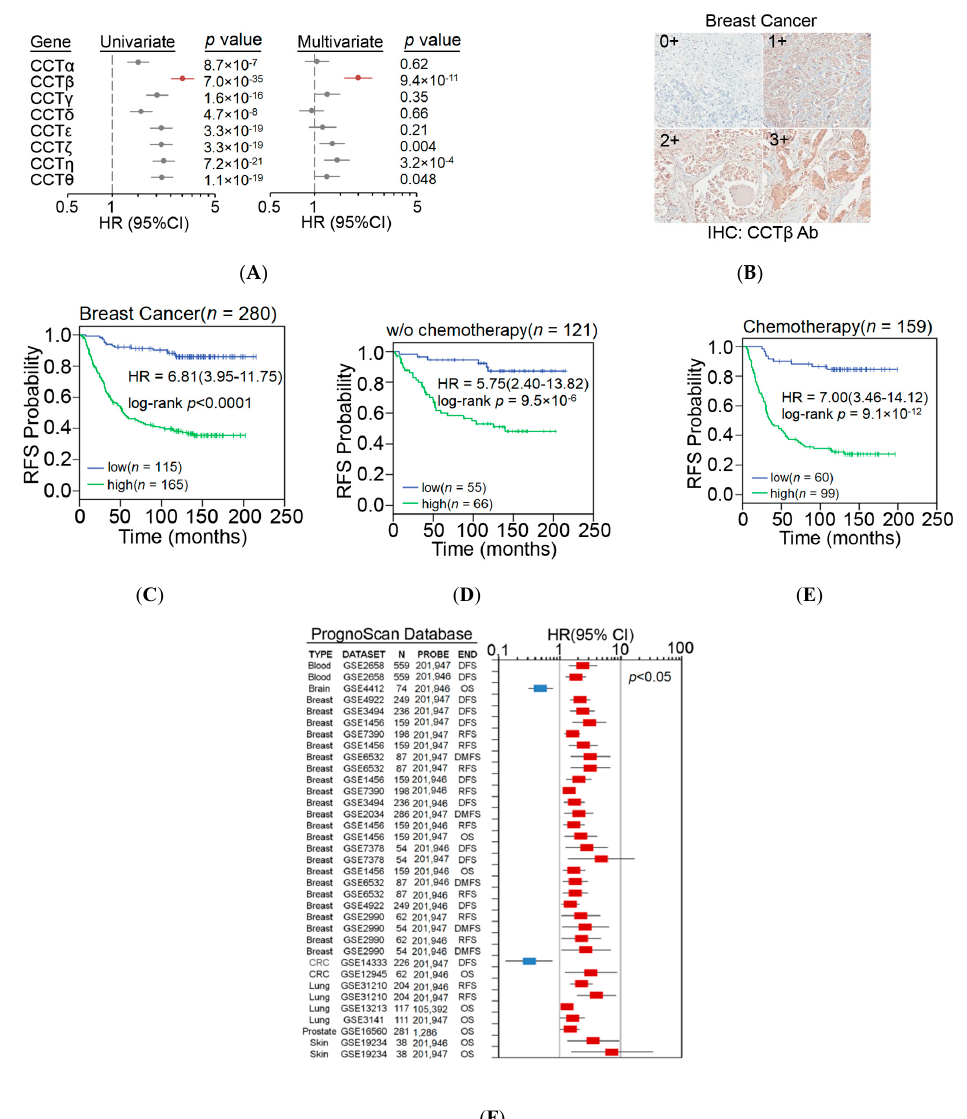
Figure 1. Endogenously high expression of CCT- β indicates poor chemotherapeutic responses in cancer patients. ( A ) Univariate and multivariate analyses under the condition of recurrence-free survival probability against CCT- β gene expression, which were obtained from the Kaplan-Meier Plotter database derived from breast cancer patients who received postoperative